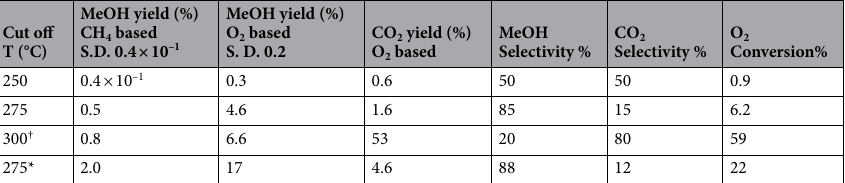
linear up to the molar ratio of 8.7 and then the yield started to fall at higher ratios. When the ratio was at 60, a decrease in the methanol yield to 4.7% was observed. The headspace gas analysis of the reactor after the reaction showed only CO, CO 2 permanent gases as shown in Figs. S5 and S6. Optimization of the temperature. The effect of temperature on methanol yield was studied by maintaining an optimum methane/oxygen ratio of 16.8 and without any dwell time as shown in Table 1. An increase in the oxygen-based methanol yield from 0.3 to 6.6% was noticed when the reaction temperature was increased from 250 to 300 °C. The lowest carbon dioxide selectivity was observed when the reaction was performed at 275 °C.